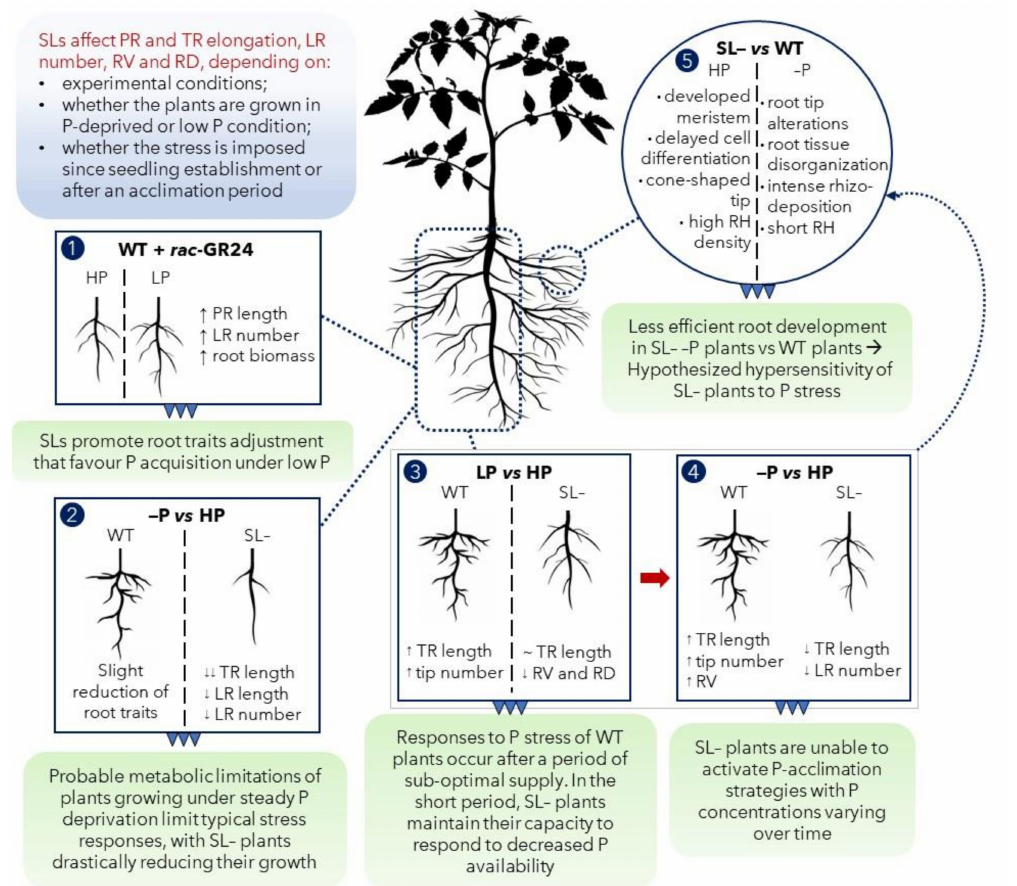
Figure 8. Conclusive conceptual summary. ( 1 ) Strigolactone (SL) analogue ( rac -GR24) application